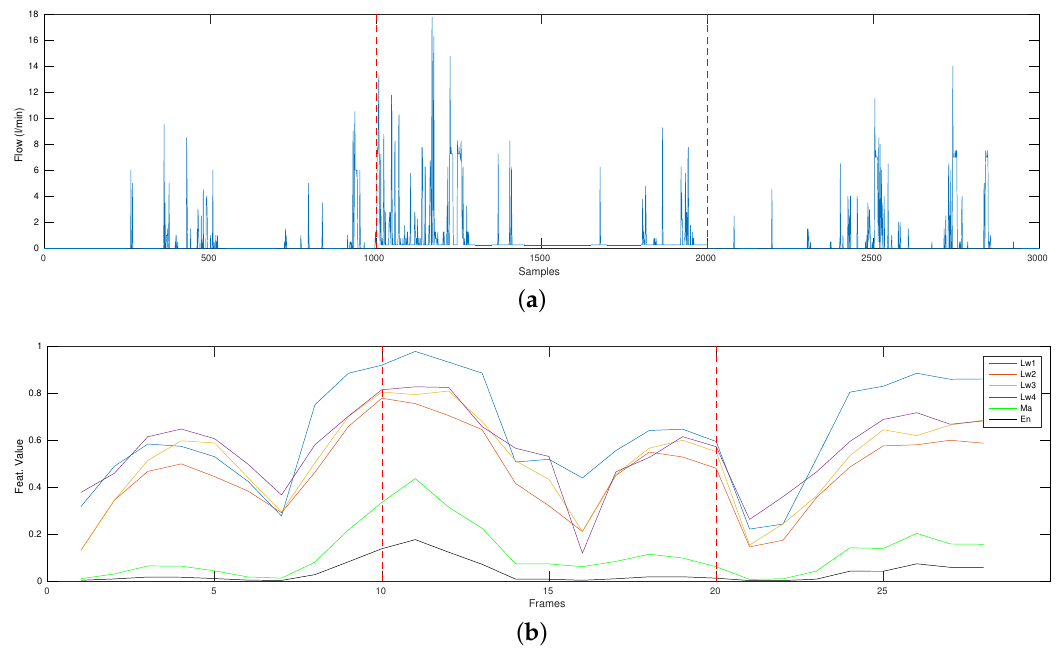
Figure 6. Example of flow data with induced leakage ( a ) and the corresponding set of extracted features ( b ). The dashed lines define the leakage start and end. For each frame, the reported features are the Ma , the En and the four components of the Lw